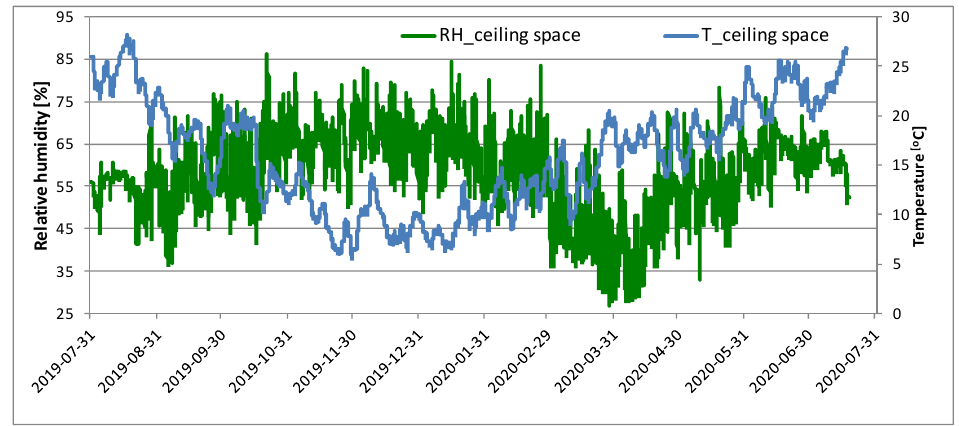
Figure 11. Changes of temperature and humidity in the ceiling space.